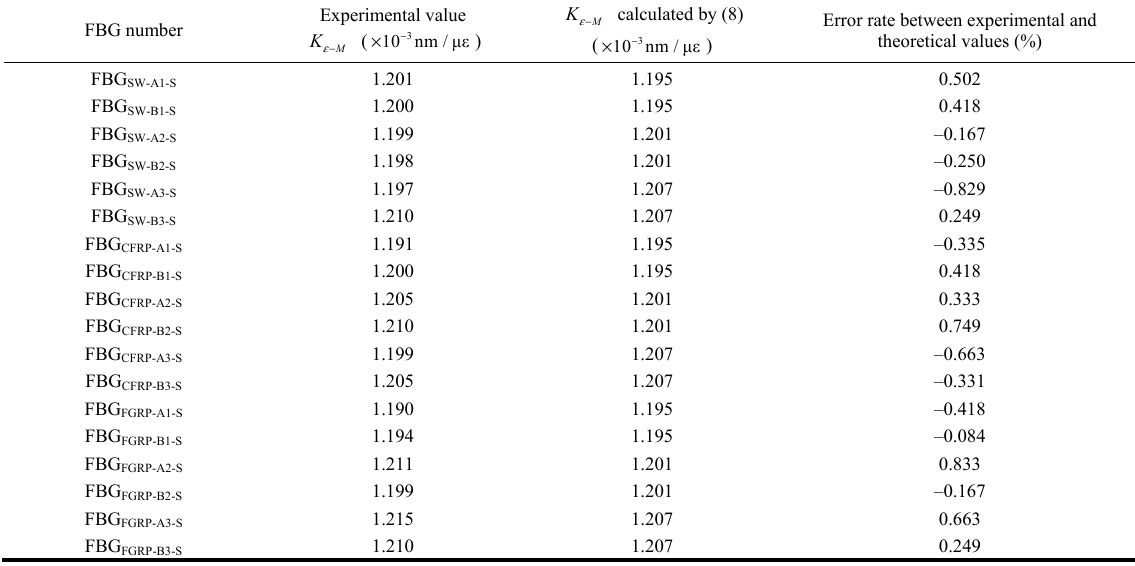
Fig. 7 FBG strain sensitivity coefficient FBG CFRP-B2-S , and (c) FBG CFRP-A3-S , FBG CFRP-B3-S . Table 4 Comparison between experimental and theoretical values of the strain sensitivity coefficient FBG number